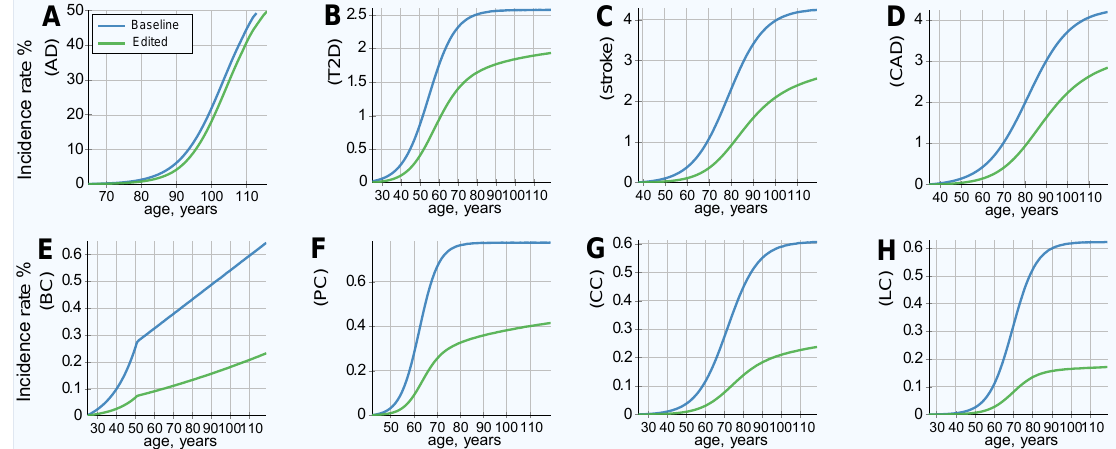
C D ) e ) A o k C t r ( ( s